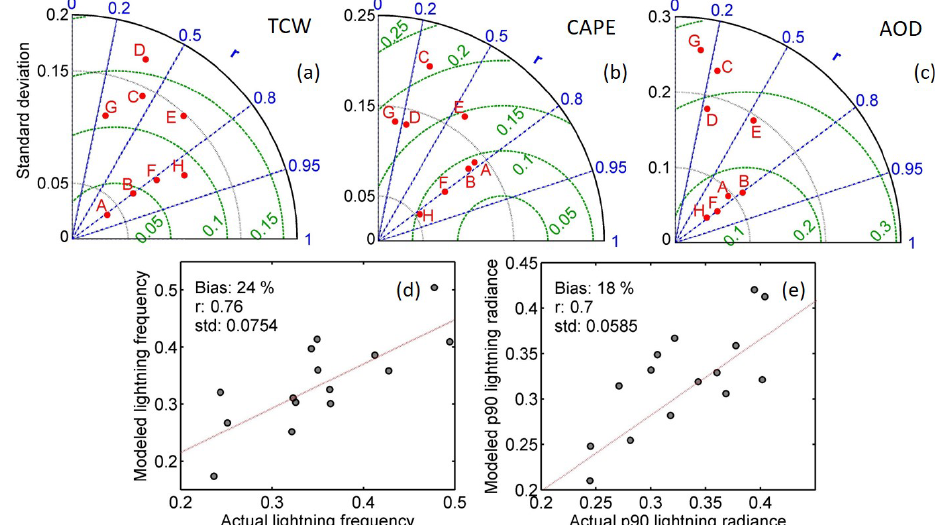
Figure 5. Taylor diagram representing the performance of the eight GCMs used in this study with respect to (a) TCWV, (b) CAPE and (c) AOD. (d, e) Covariation between regressed lightning properties from the model mean with respect to observations for average flash rate (km 2 per month) and the 90th percentile of radiance (Jm − 2 steradian − 1 s 1 ).